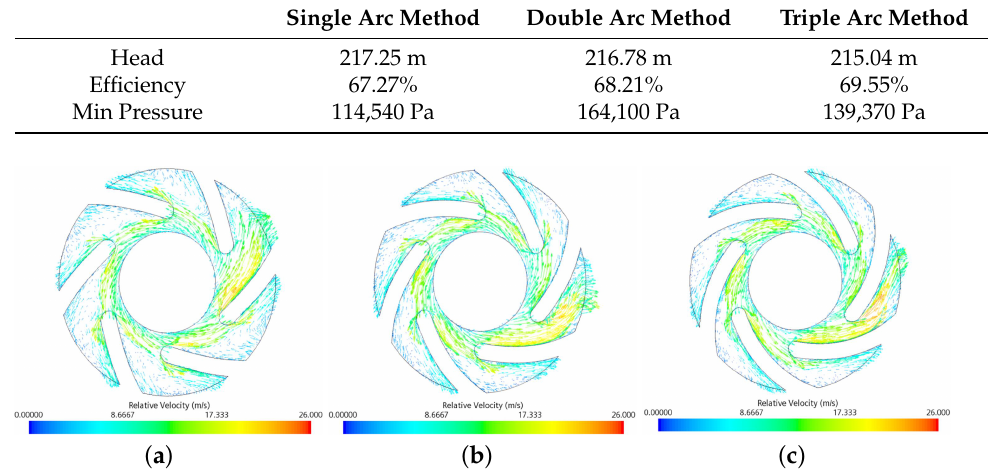
Table 7. Performance of various impellers.